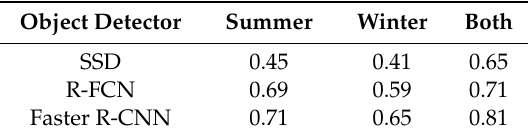
Table 6. Comparison of di ff erent object detectors between summer and winter seasons. The metric is